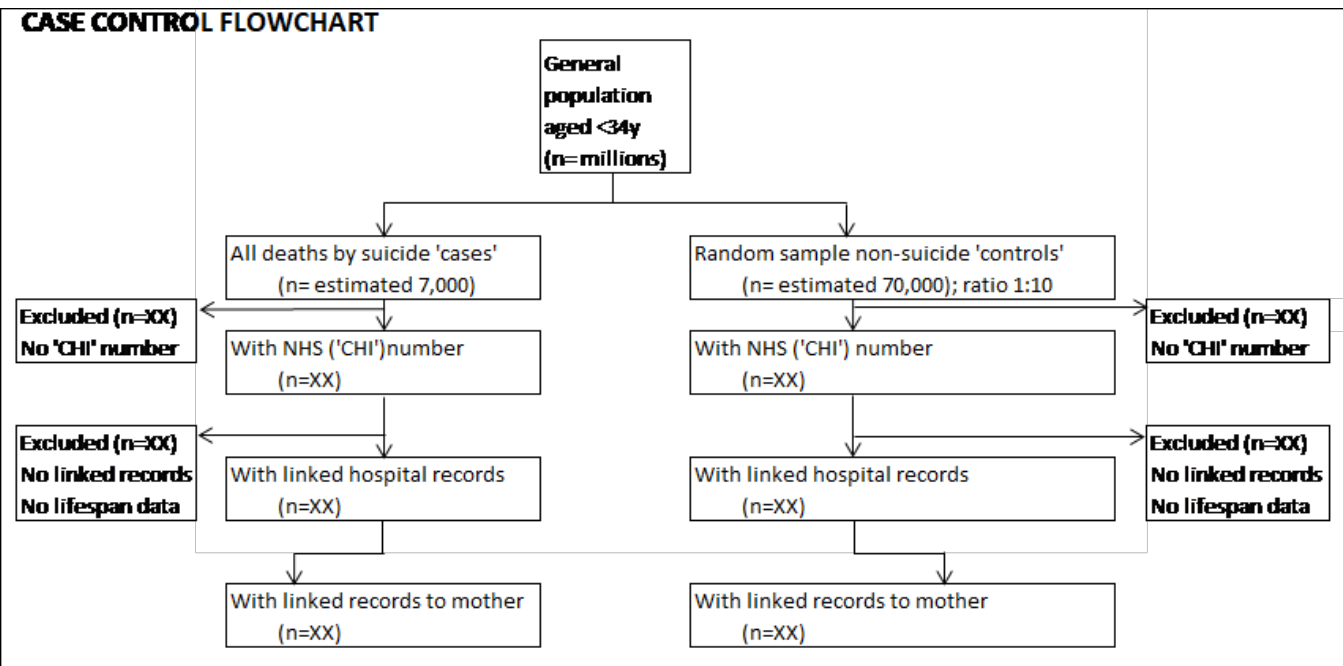
Figure 1: Flow diagram of mothers and babies eligible for inclusion in study